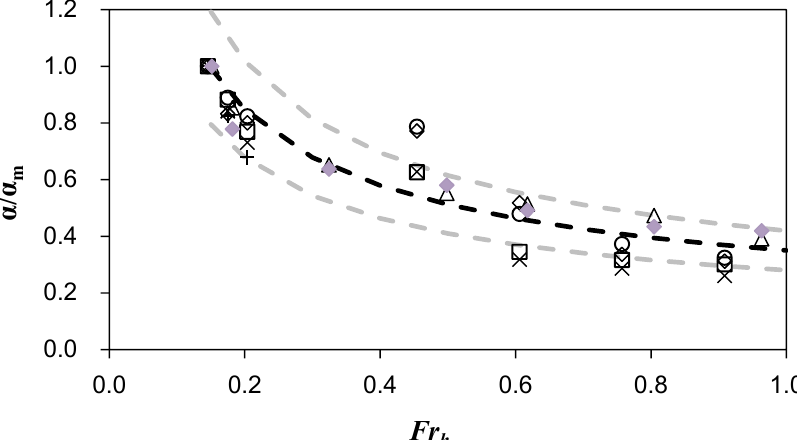
Figure 8. Wake angles versus velocity U with different rod shapes (f1r1: round rod, f1s1: square rod, f1w1: rectangular rod with wide edge, f1n1: rectangular rod with narrow edge.).